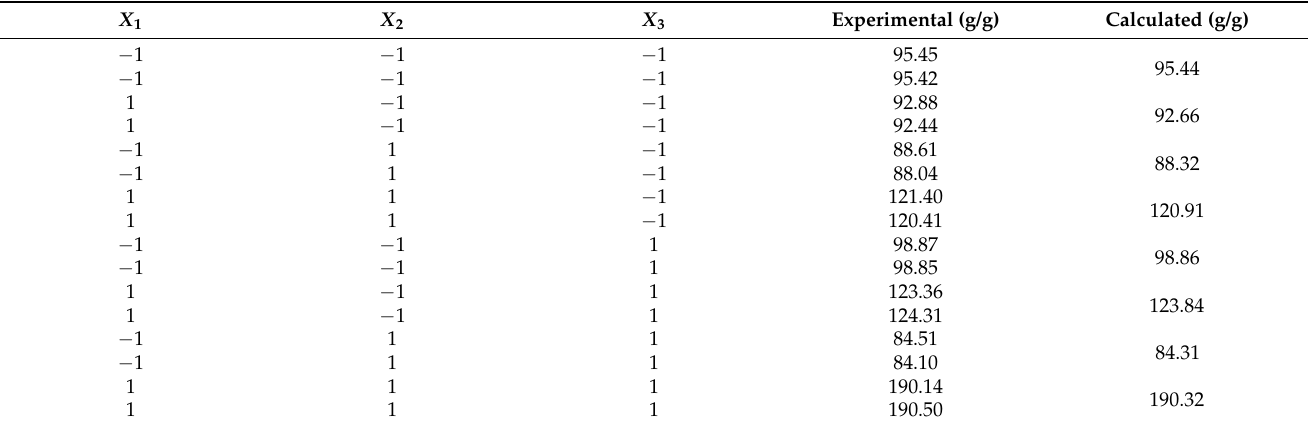
Table 2. Experimental results and calculated results by the models his is a